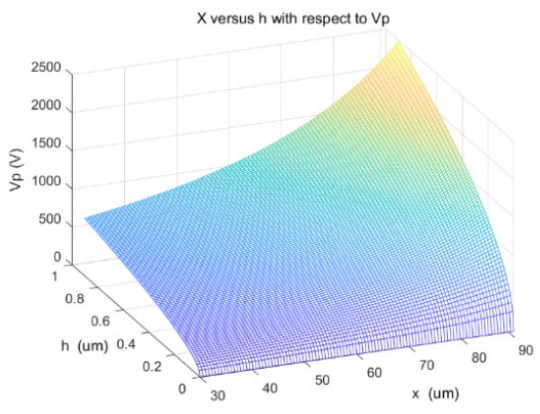
Figure 6. Relationship between position x , height h , and pull-in voltage.